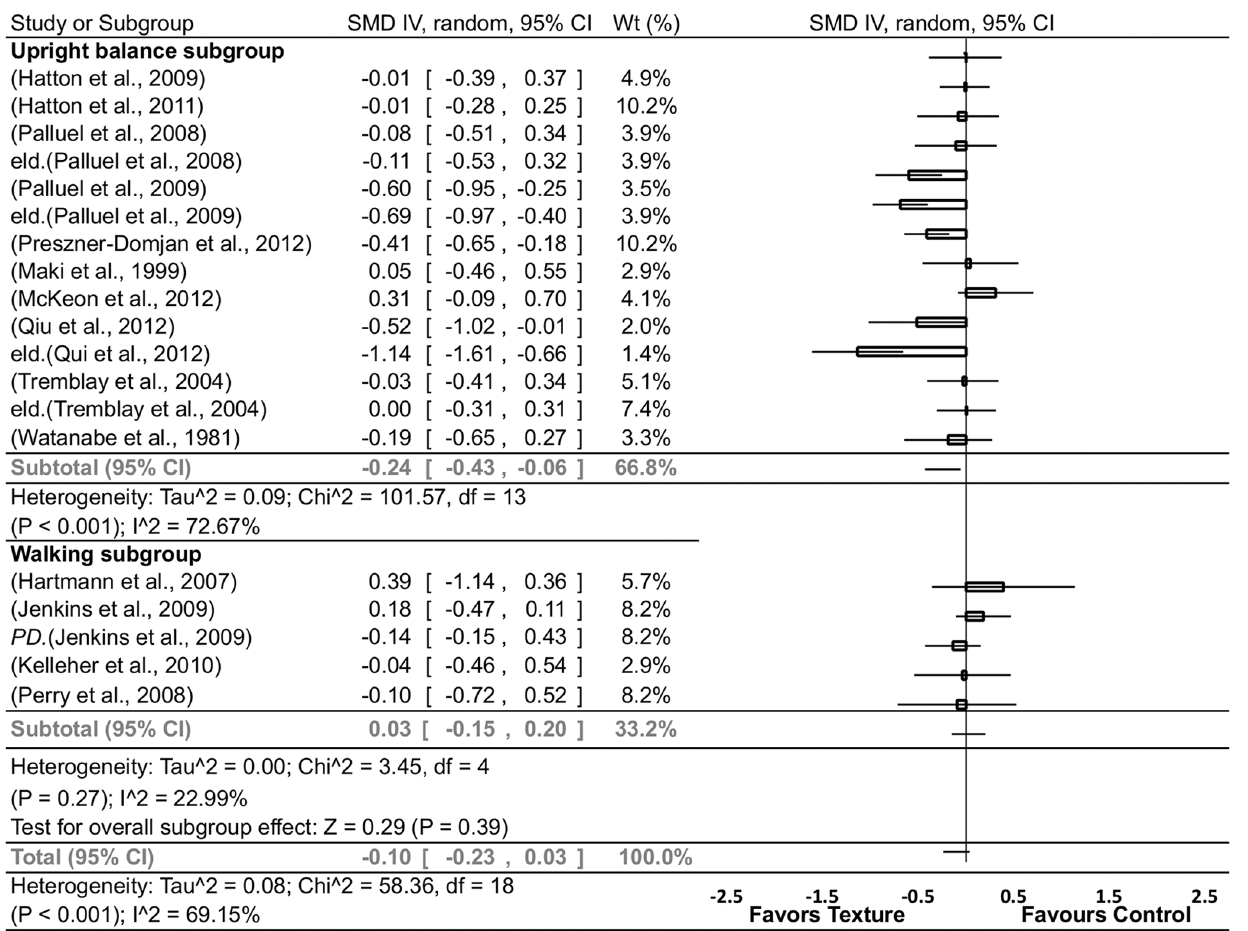
Figure 4. Forrest plot summary of textured material effects on perceptual-motor performance in upright balance or walking tasks. CI=confidence interval; eld.=elderly group; PD=Parkinson’s disease; IV=inverse variance; random=randomized; SMD=standardized mean difference; Wt=weight. Note: within groups vs baseline and between [8,11] groups vs baseline.